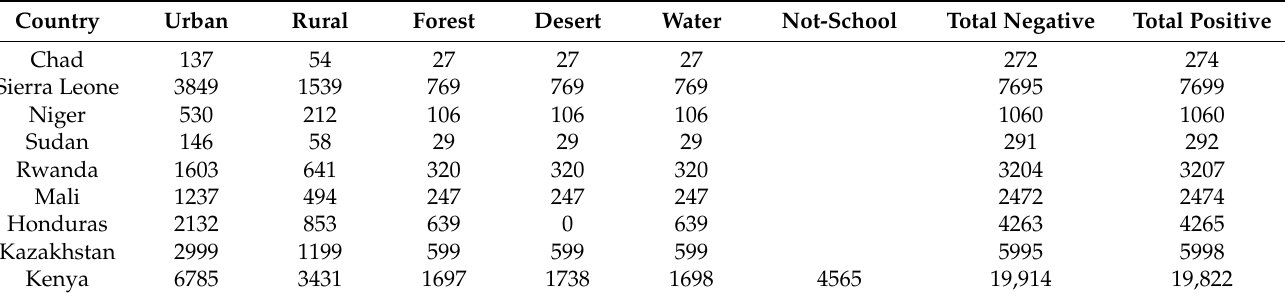
Table 2. Training datasets for country models that include negative (not-school) and positive (school) categories. Not-school includes buildings from urban and rural, forest, desert, water, and “NO” school tag list in Table 1.